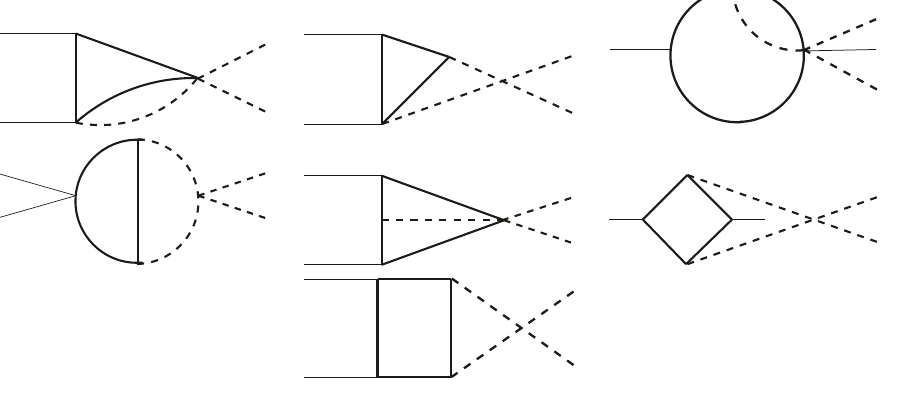
Figure 19 . Topologies of the integral expressions from the form factor ~ F 0 ;b